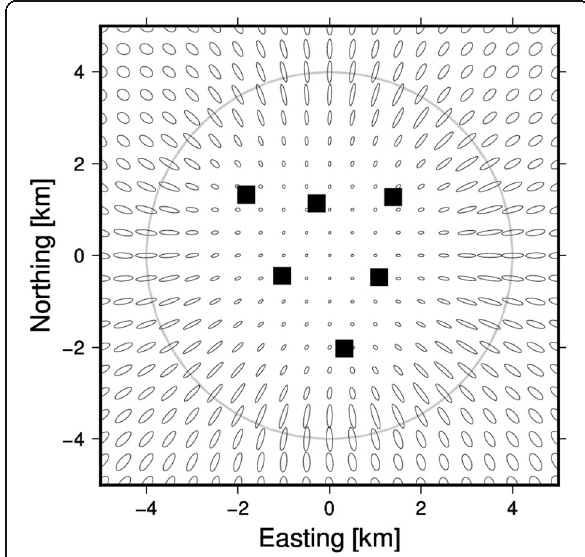
Fig. 7 Error ellipses calculated using DOP analysis procedure.The orientations of the error ellipses correspond to line-of-sight directions from an observation position to the array center. The black squares represent the six